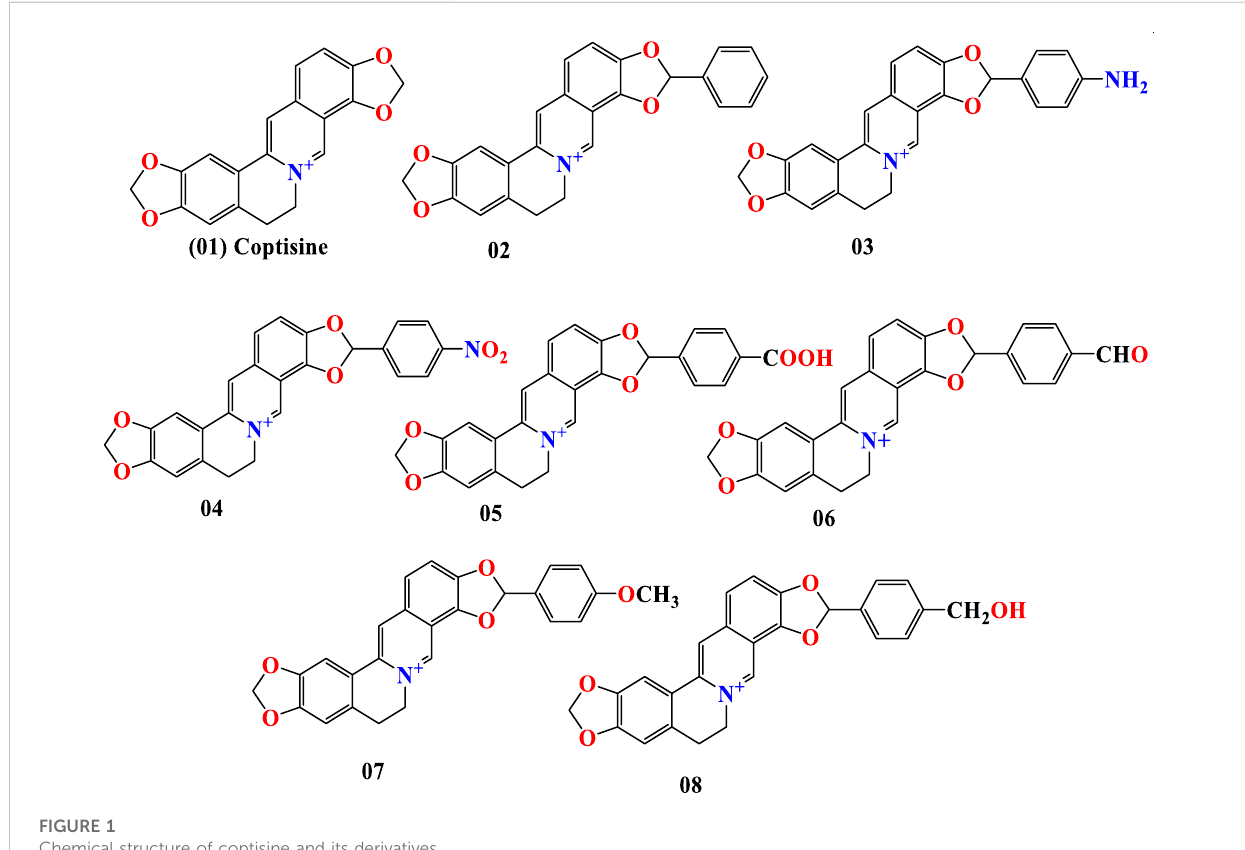
FIGURE 1 Chemical structure of coptisine and its